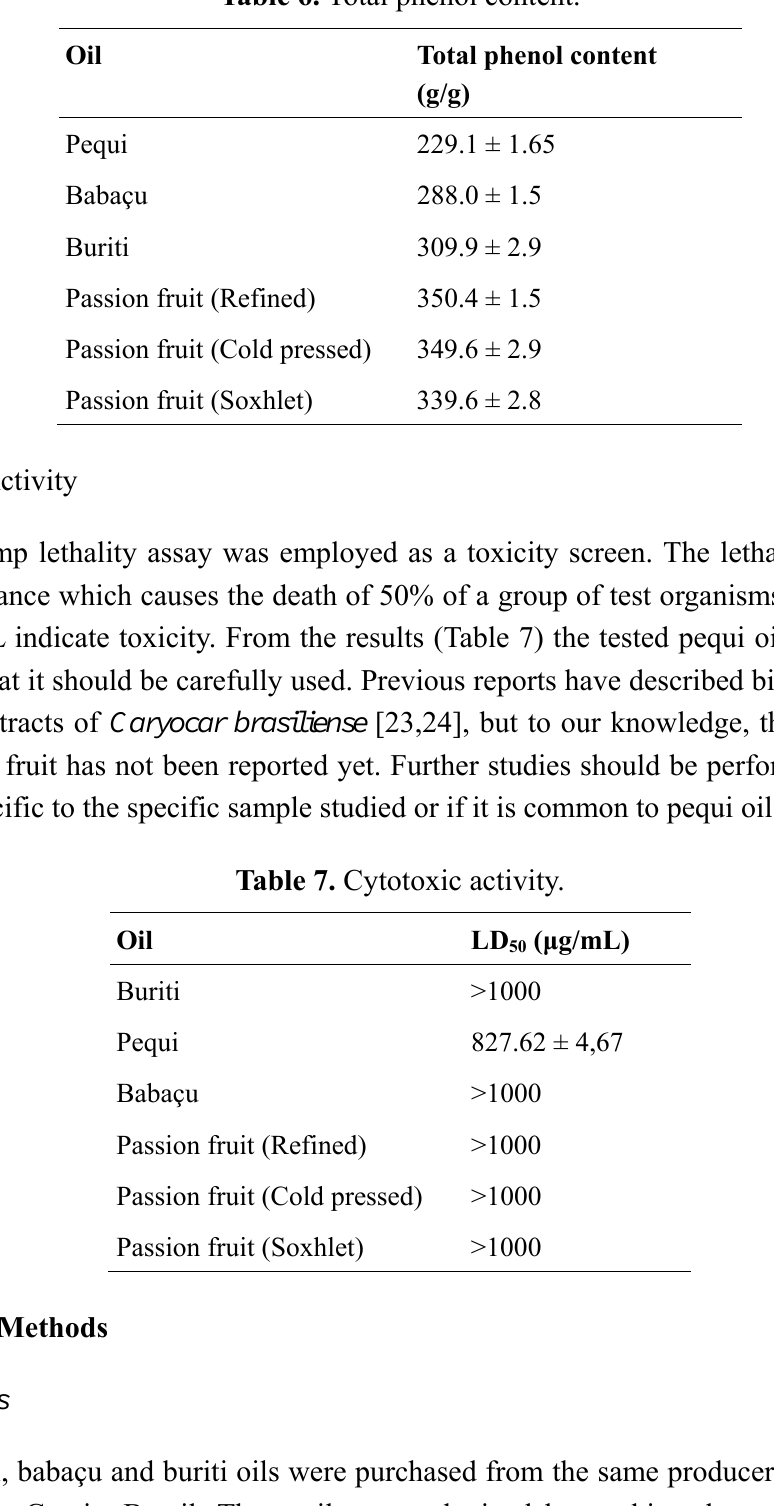
Table 6. Total phenol content.